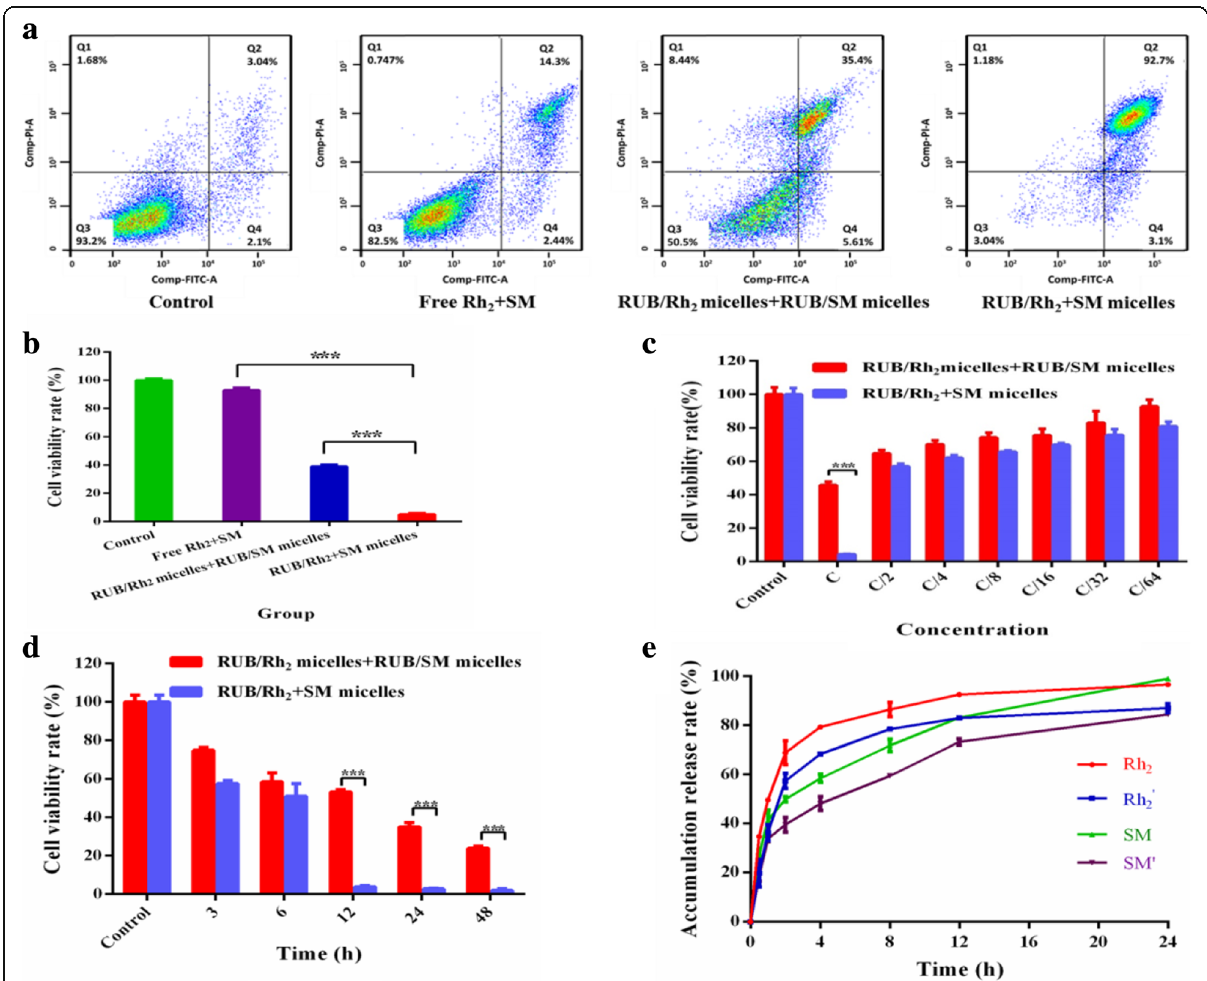
Fig. 7 The anti-cancer effects of RUB-based micelles on MCF-7 cells. a Apoptosis of MCF-7 cells treated with indicated formulations of Rh2 (2.19 mM) and SM (0.26 mM) for 24 h was analyzed by flow cytometry using Annexin V-FITC/PI staining. b Cell viability of MCF-7 cells was measured by MTT method, which was treated with indicated formulations of Rh2 (2.19 mM) and SM (0.26 mM) for 24 h. c , d Time- and dose-dependent manners of cell viability of MCF-7 cells treated with indicated formulations were measured by MTT method. c represented for Rh2 (2.19 mM). SM ’ s concentration was 0.26 mM. e In vitro release profile of Rh2 and SM from RUB/Rh2 + SM micelles and RUB/Rh2 micelles + RUB/SM micelles. Error bars indicated s.d. ( n =3). *** P <0.001 (two-tailed Student ’ s t